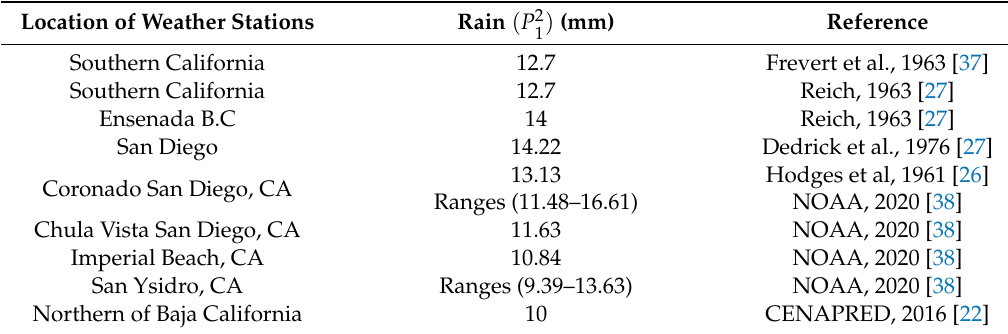
) for California and Baja California. 1